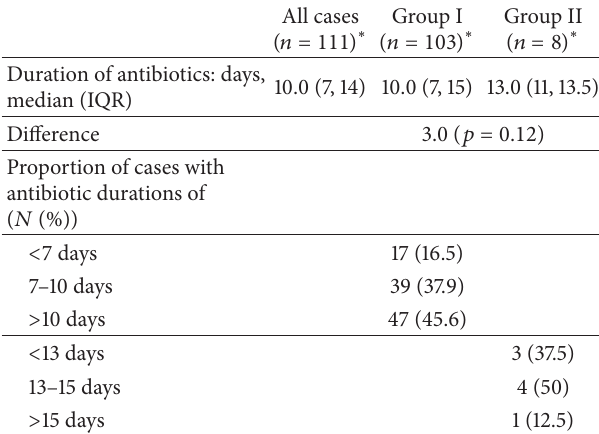
Table 5: Duration of therapy according to